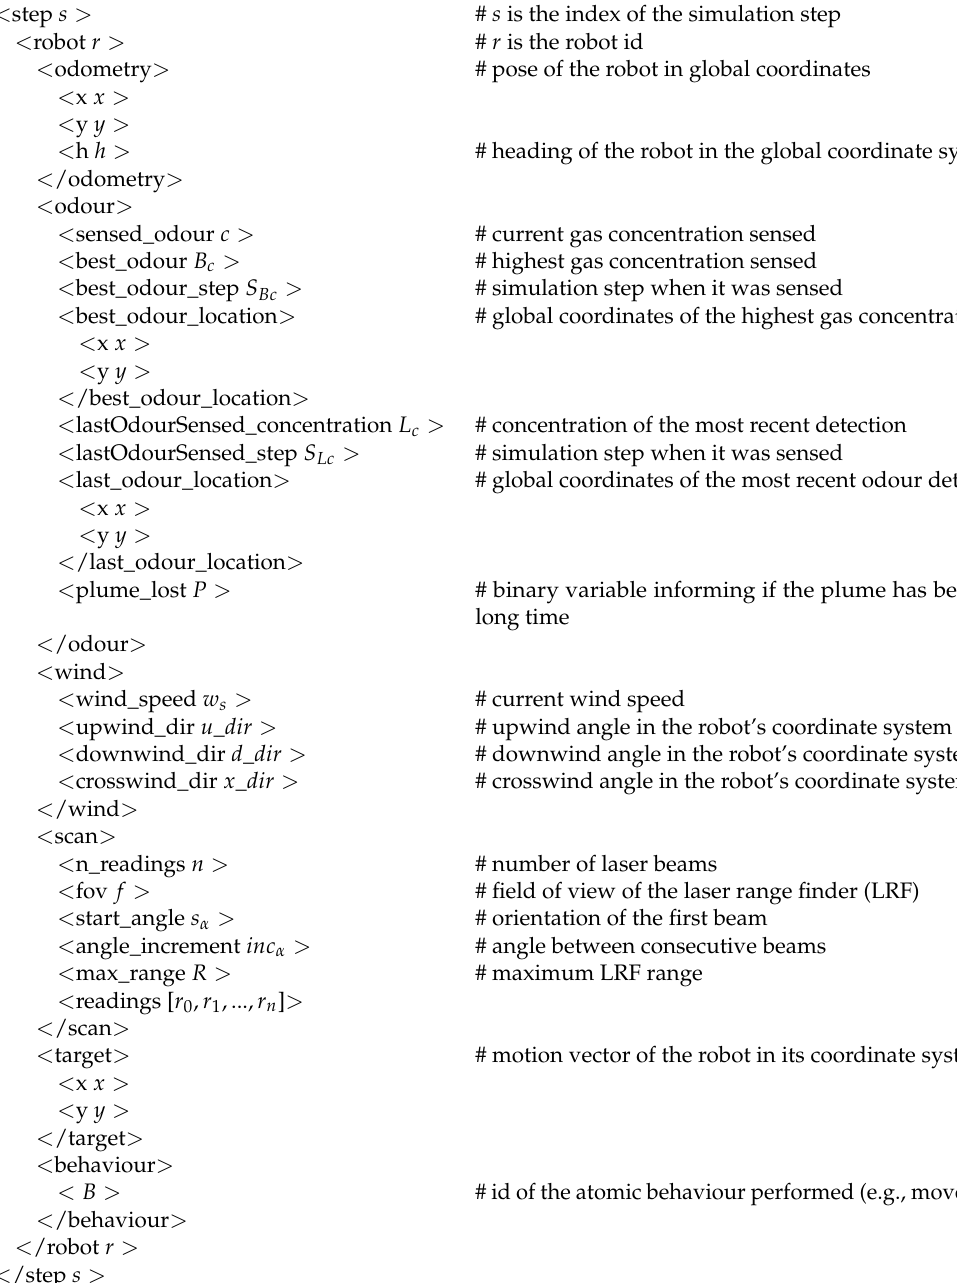
Table 2. Structure of the behavioural